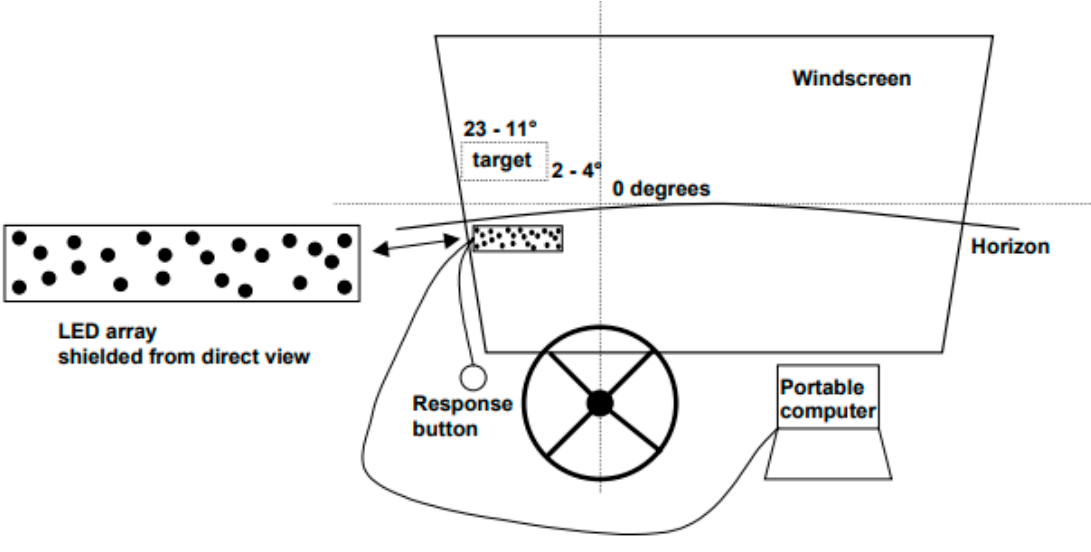
Figure 2. Peripheral Detection Task set-up [21].